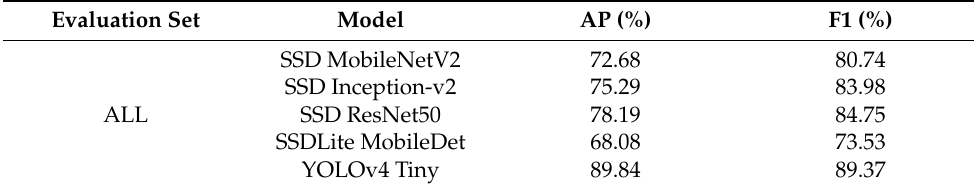
Table 8. Results of AP and F1 obtained from experiment #3 considering all detections (confidence threshold of 0%).